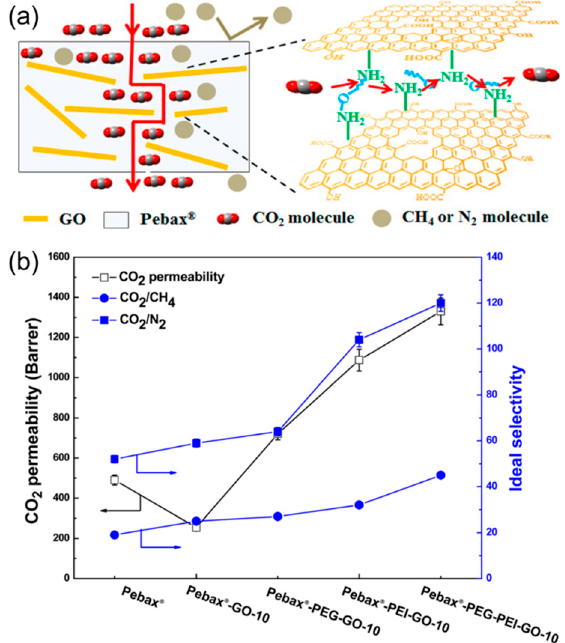
Figure 10. ( a ) Schematic of CO 2 -facilitated transport in the MMMs containing the modified GO in PEBA. ( b ) CO 2 /gas separation properties of PEBA and MMMs containing 10 wt% fillers in the humidified condition. Adapted with permission from [40]. American Chemical Society (2015).